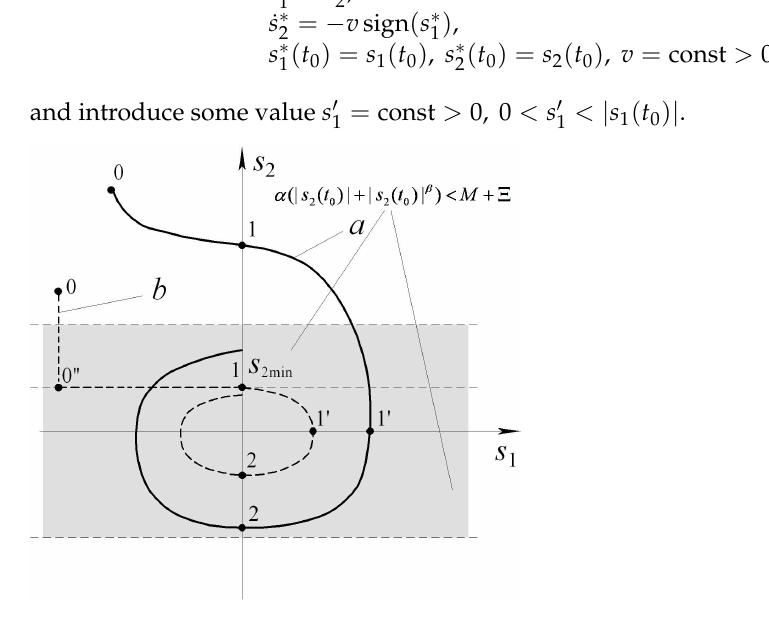
Figure 2. Phase portraits under initial conditions from the second and fourth quadrants (Situation